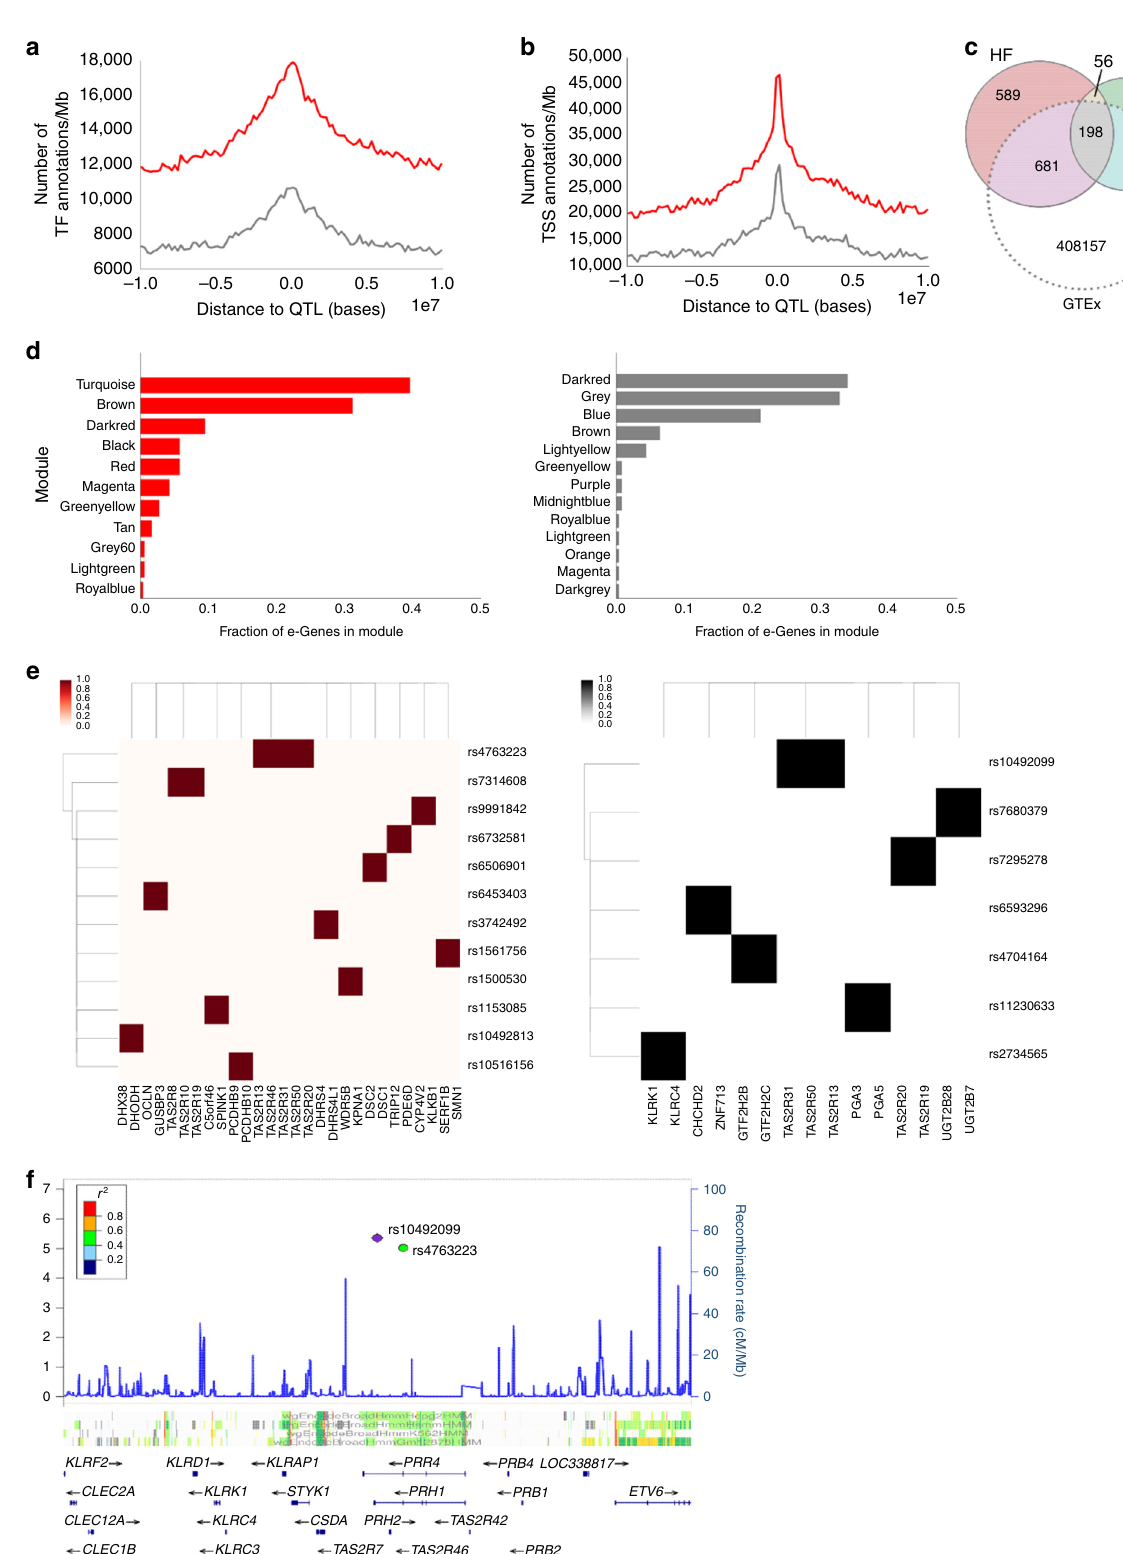
Fig. 2 High-quality tissue expression reveals previously undetected cardiac eQTL associations. Transcription factor ( a ) and transcription start site ( b ) annotation to eQTL distance distributions for failing (red) and control hearts. c Number of cis eQTLs found for each group that overlapped with GTEx eQTLs. d Fraction of modules with genes found to be controlled by at least one eQTL in HF (red, left) and controls (gray, right). e Heat map indicators for variants controlling multiple genes in-cis in HF (red, left) and controls (gray, right). In the rows are SNPs controlling genes (columns) colored intensely if the SNP controls the gene. f Variants from one locus control a network of G-protein-coupled receptors TAS2R present in both the failing and control